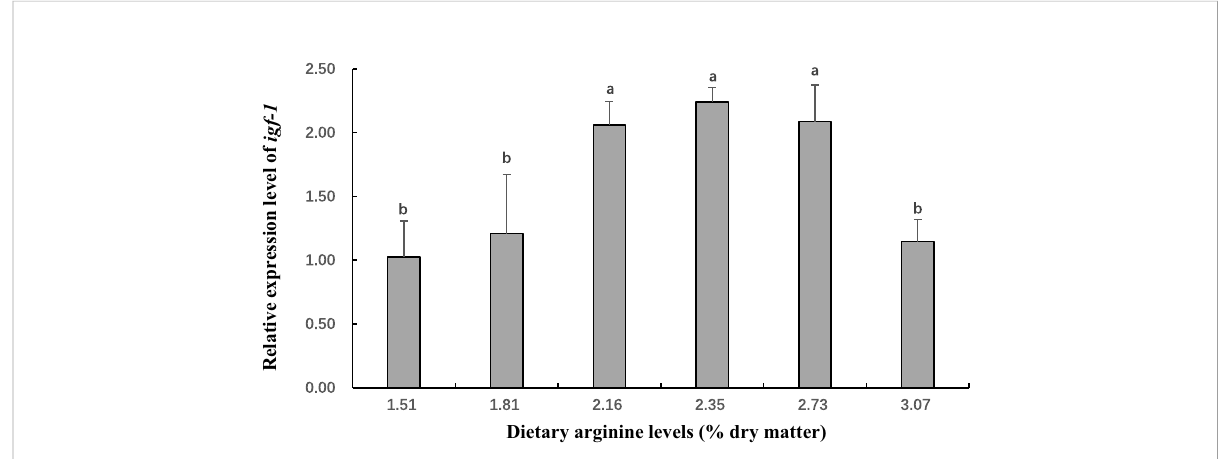
FIGURE 3 The gene expression (Insulin-like growth factor 1 ( igf-1 ) in hepatopancreas) of postlarval Scylla paramamosain fed diet with different arginine levels. Means in the same row with different superscripts are signi fi cantly different (P<